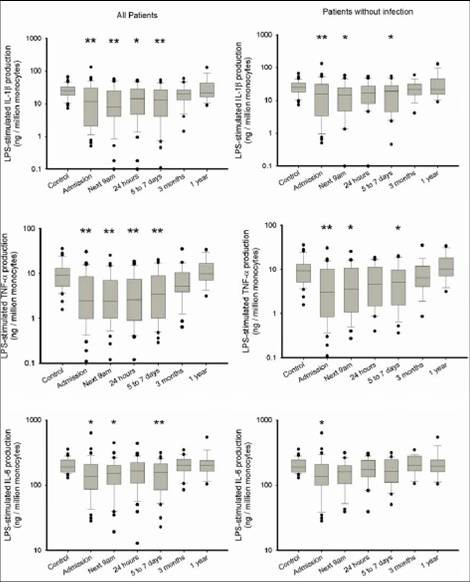
Lipopolysaccharide-stimulated cytokine production kinetics in all patients and patients without infection (in the 6 weeks preceding assessment). Box plots show medians, 10th and 90th percentiles and outliers. The 24 hour timepoint includes "next 9 am" data where admission was between 07:00 and 11:00. *p ≤ 0.01 **p ≤ 0.001 (relative to controls).